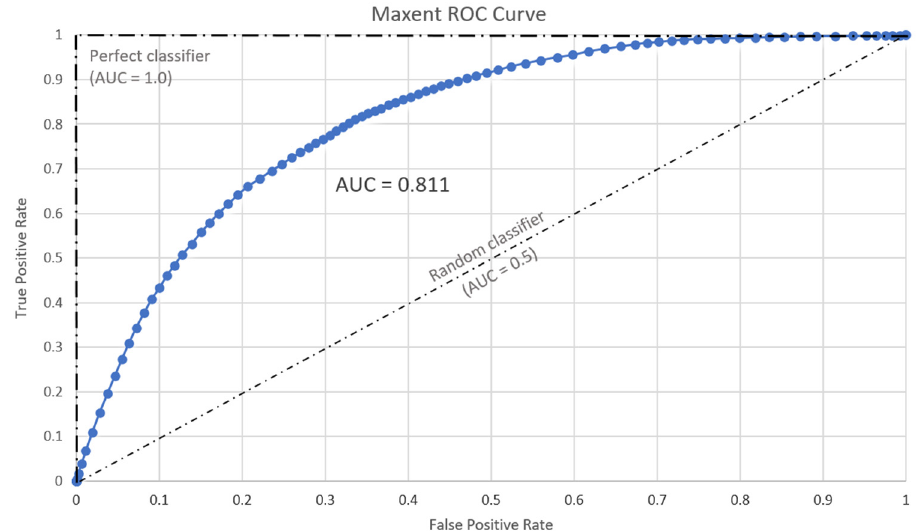
Figure 2. Receiver operating characteristic (ROC) curve representing the compromise between true positive rate and false positive rate. A perfect model would have an ROC curve right to the left and top axes, maximizing the area under the curve (AUC) at 1.0. This model has an AUC curve of 0.811, which shows that the model predicts much better than a random classifier.